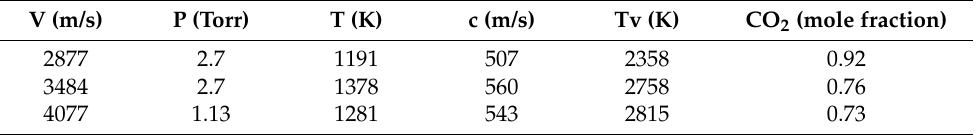
Table 3. Estimated X2 freestream conditions for MSL project